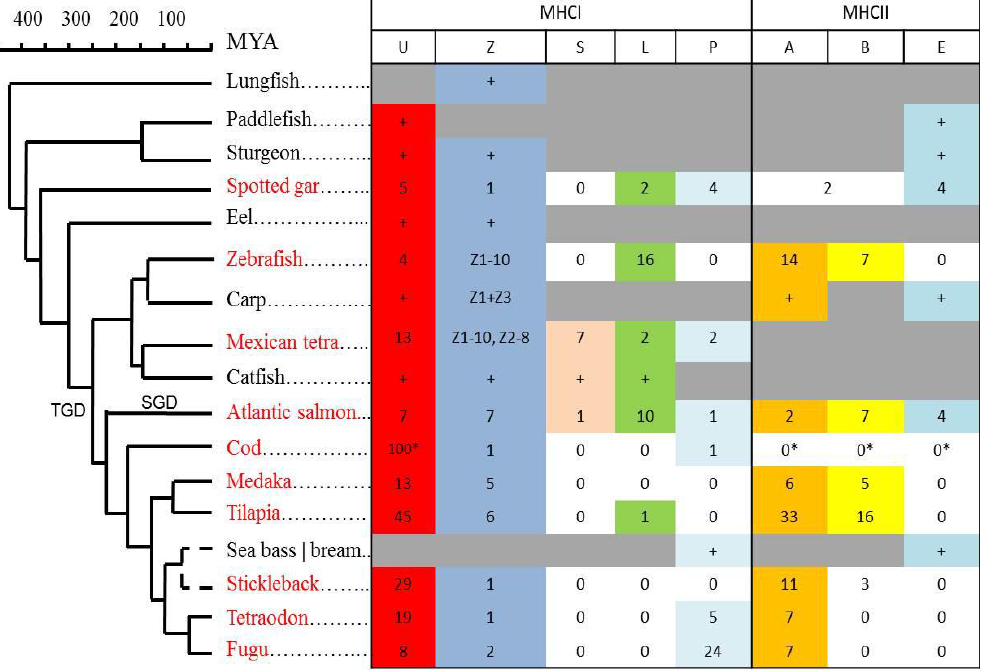
Figure 7. Phylogenetic distributions and gene count for MHC class I and class II lineages. Presence of MHCI (U,Z,S,L,P; data from [19]) and MHCII (A,B,E; data from [18]) lineages are shown in a tabular format linked to the phylogeny of each individual species. Species with sequenced genomes that have been studied in detail are shown using red font. Number of genes within each lineage are shown, where the “+” refers to at least one sequence identified in species without sequenced genomes. Presence of a lineage is marked using individual colors. Lineages not identified are shown using white cells labelled 0, where the MHCII data for cod originates from Star et al. (* [33]). Lineages we have not looked for or there is insufficient data to conclude are shown using grey cells. Number of Z1–Z3 lineage genes are shown for zebrafish and Mexican tetra, but unknown for carp, lacking sequenced genomes. For spotted gar, two MHCII sequences could not be assigned as A or B and are thus shown as A/B [18]. The P lineage was found in sea bass, while the E lineage was found in sea bream.